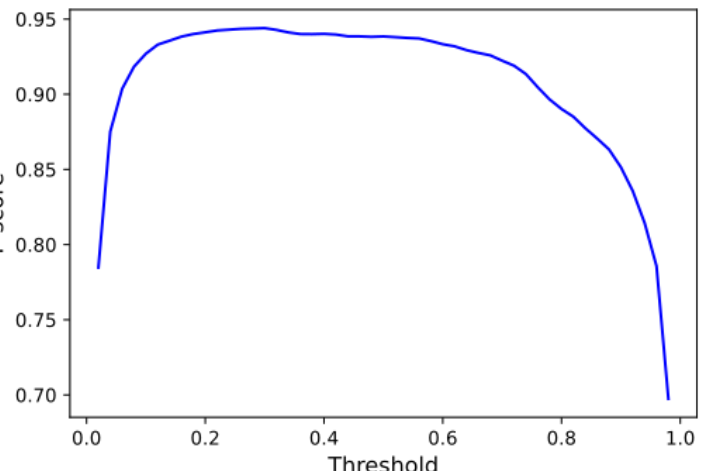
Figure 6. CNN accuracy in terms of F-score on one single track of the Slakh2100 dataset as a function of the threshold. The horizontal axis corresponds to the threshold value and the vertical axis is the F-score